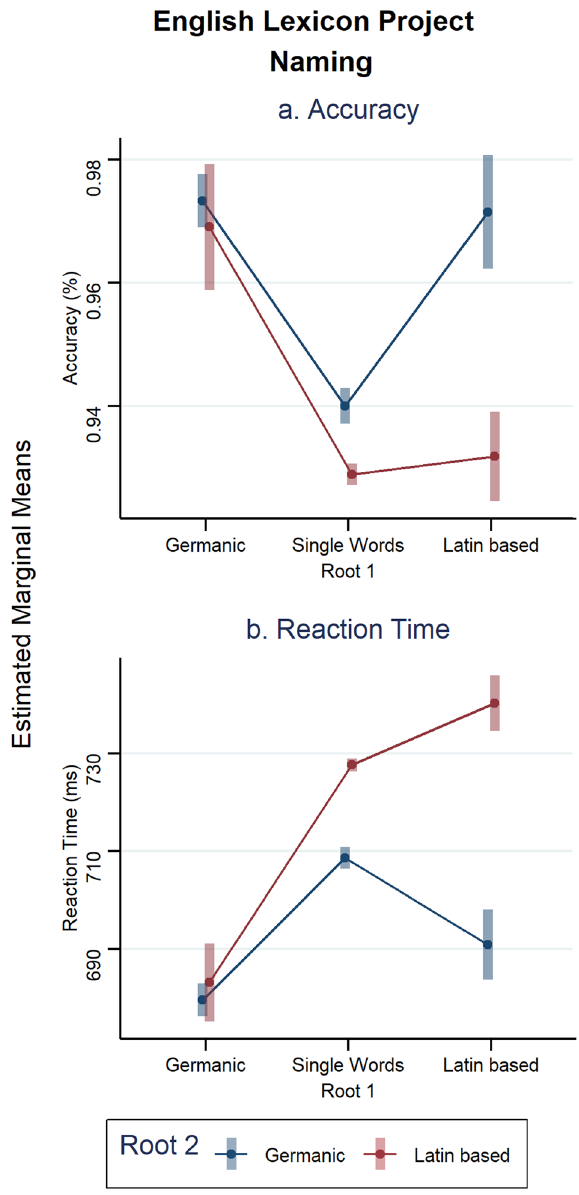
Fig. 3 English monolinguals are least accurate and slowest for Latin-Latin based